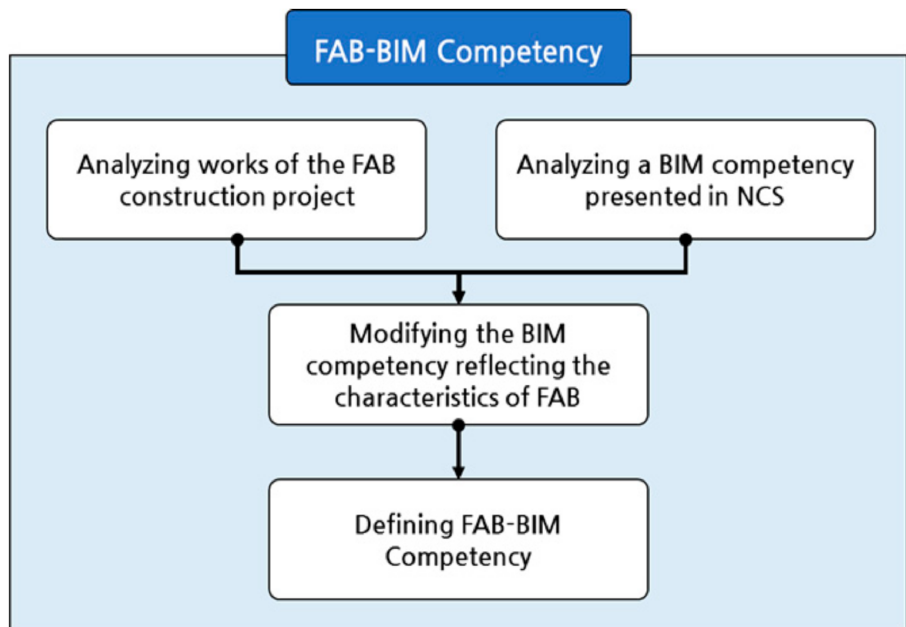
Figure 4. FAB-BIM competency through analysis of work in FAB construction